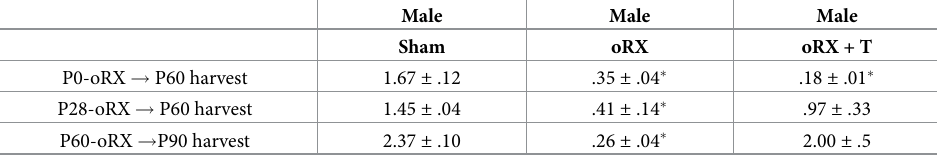
Table 1. Seminal vesicle weight (experiment 2).